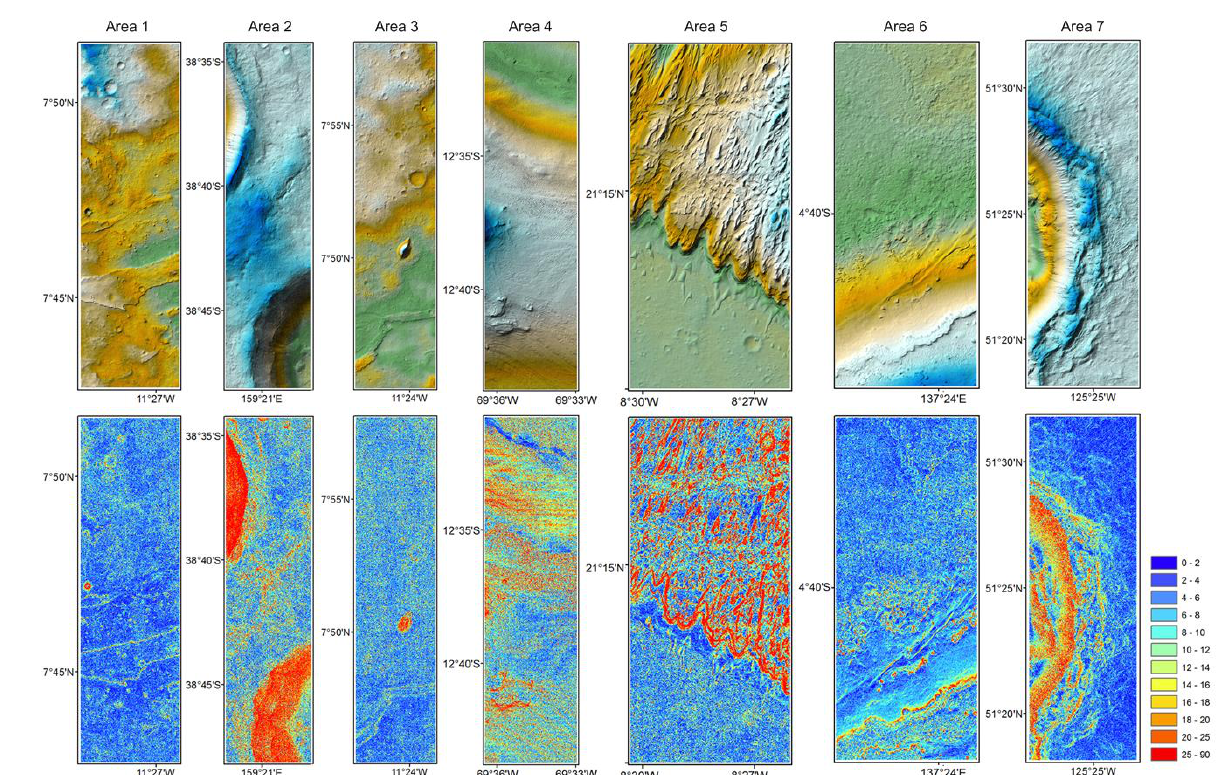
Figure 1. DEMs and slope maps of the seven HiRISE datasets used in the